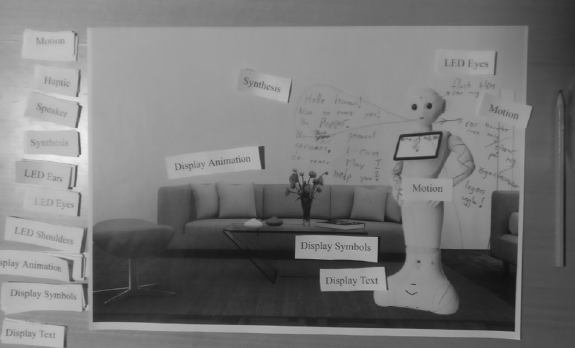
Figure 7: Example of what the shared design surface can look like during the label